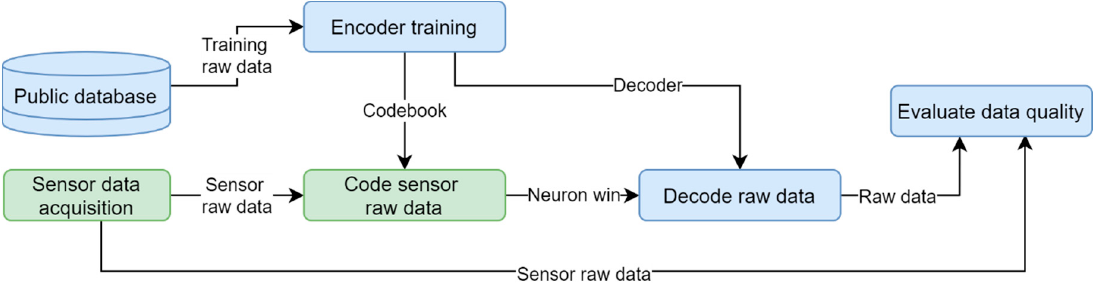
Figure 8. Online (blue) and offline (green) compressor model validation.